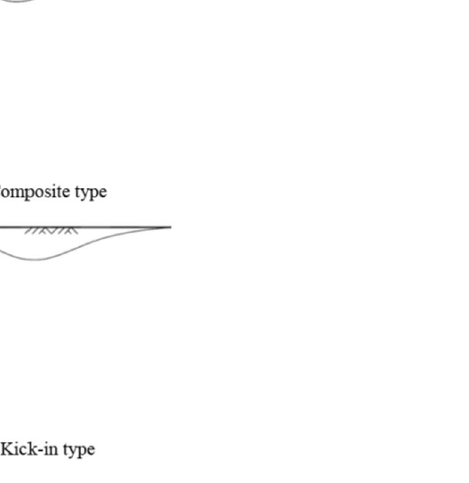
Figure 1. Typical profiles of deflection of retaining structures 18